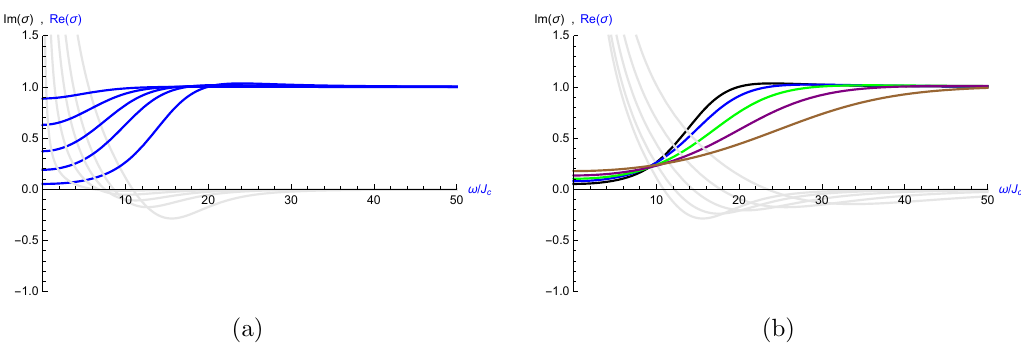
Figure 6. Plots of Real and Imaginary (light grey) part of conductivity (cid:27) vs frequency !=J c , at zero chemical potential, when (cid:21) = 0. Here J c is the critical value source at which the superconductor phase begins to exist. In (a) we have (cid:12)xed the Lagrangian parameters to (cid:11) 1 = (cid:11) 2 = 1, and (cid:12) = 0 : 6, and we have increased J starting from J c . We notice that at large values of J , magnitude of the gap in the conductivity plot saturates and becomes maximal. In (b) we have (cid:12)xed the value of the source J , to some large value much above J c , where the gap is maximal, and chosen the Lagrangian parameters to be (cid:11) 1 = 1, (cid:11) 2 = 1, (cid:12) = 0 : 6 ; 0 : 7 ; 0 : 8 ; 0 : 9 and 1.0, from brown to black in that